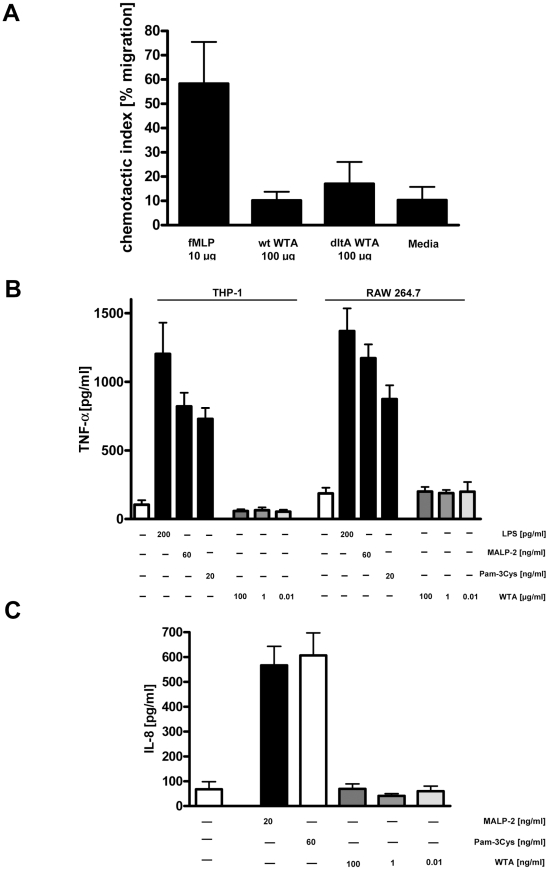
WTA fails to directly induce chemotactic migration or cytokine induction.A) The chemotactic activity of WTA was assessed in a transwell assay. Shown are means (n = 3) and SD of the chemotactic index (% of cells that migrated from the upper compartment towards the stimulus in the lower compartment). The positive control fMLP induced strong chemotactic migration whereas wt and dltA WTA failed to affect neutrophil migration (p>0.05 for WTA vs. media by Mann-Whitney analyses). B) Production of TNF-α in the human monocyte cell line THP-1 and the mouse macrophage cell line RAW 264.7 after stimulation for 8 h. LPS, Pam3Cys and MALP-2 stimulated a potent response whereas wt WTA at 100, 1 or 0.01 µg/ml failed to induce cytokine production (WTA vs. media >0.05 by two-tailed Student t-test). Shown are means and SD, n = 3. C) Production of IL-8 in TLR-2 transfected HEK293 cells after stimulation for 10 h. Pam3Cys, MALP-2 stimulated a potent response whereas wt WTA failed to induce cytokine production at concentrations of 100,1 or 0.01 µg/ml. Shown are means and SD, n = 3 (WTA vs. media p>0.05 by two-tailed Student t-test ).